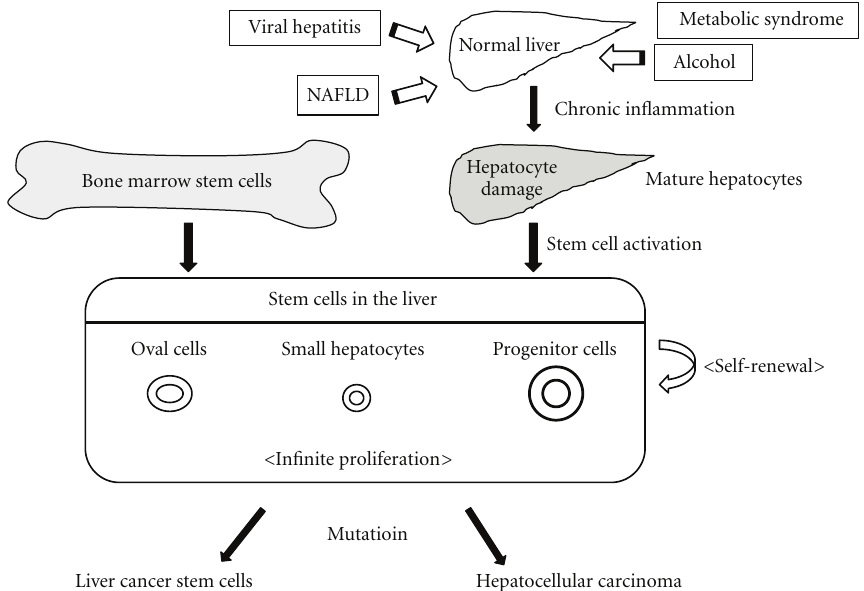
Figure 1: The etiology of HCC has been reported to be related to a variety of diseases such as viral hepatitis, alcoholic hepatitis, nonalcoholic fatty liver disease (NAFLD), and metabolic syndrome including diabetes mellitus. Regeneration of damaged hepatocytes reveals the activation of stem cells. The abilities of self renewal and infinite proliferation are closely related to the development of hepatocellular carcinoma (HCC). Stem cells in the liver are divided into several types, including oval cells, small hepatocytes, and progenitor cells. HCC cells and liver cancer stem cells could derive from mutation of these stem cells. The origin of the stem cells could be from either mature hepatocytes or bone marrow